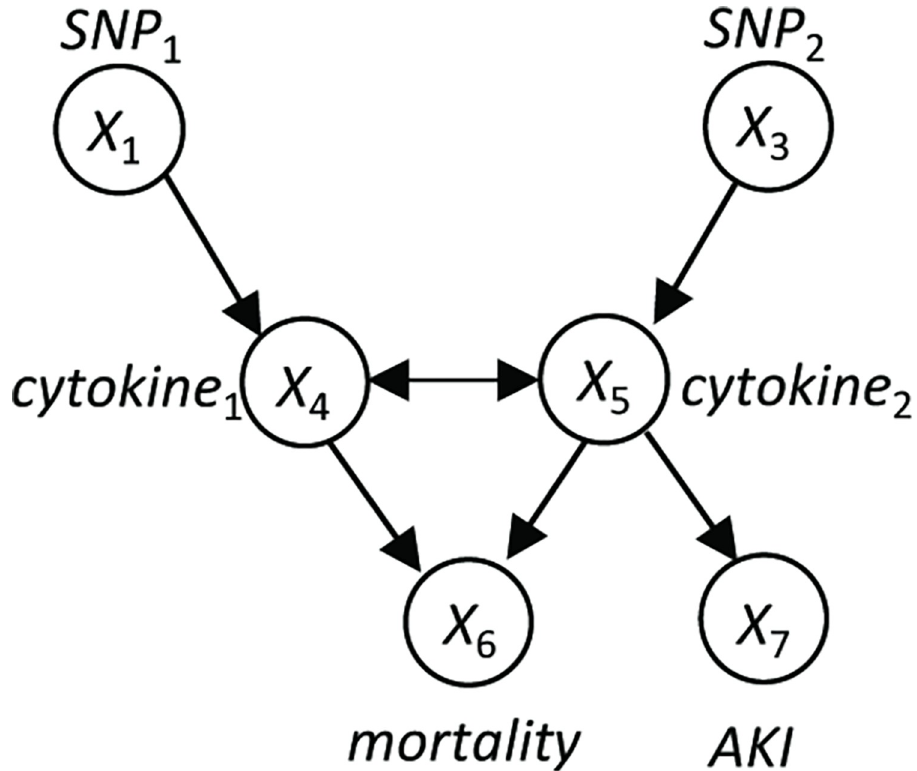
Fig 8. A MAG representing the causal model in Fig 7 when the node pneumonia is